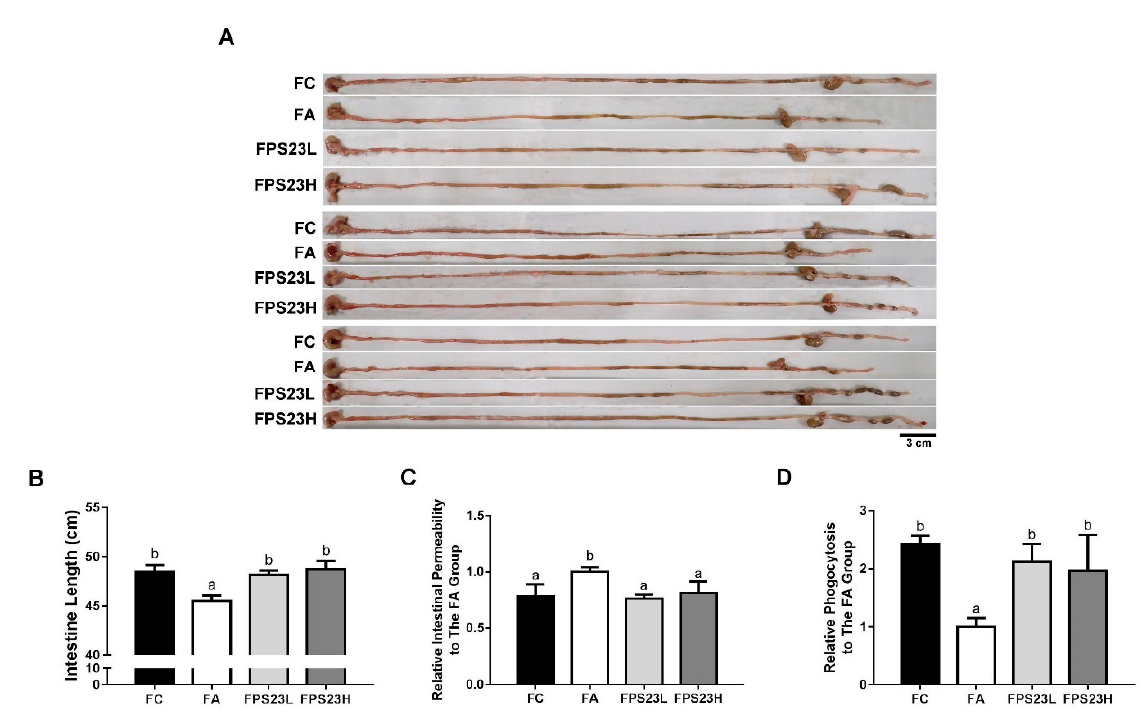
Figure 2. Spearman’s correlation analysis of the gut microbiota of SAMP8 mice. Asterisk (*) indicates p < 0.05. n = 4.